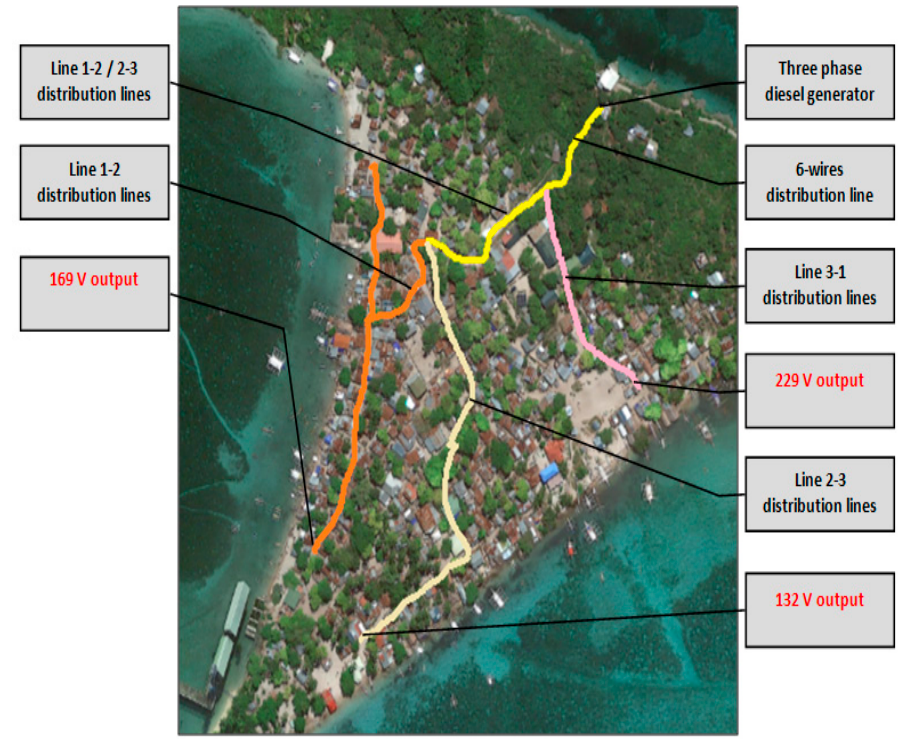
Figure 3. Electrical distribution setup of Gilutongan Island.